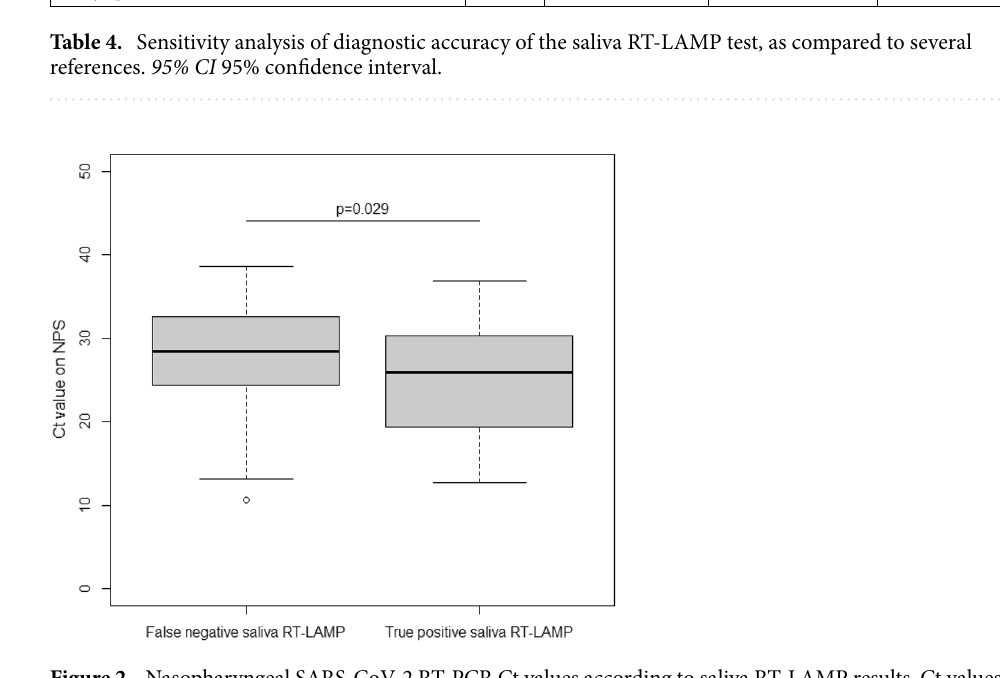
Figure 2. Nasopharyngeal SARS-CoV-2 RT-PCR Ct values according to saliva RT-LAMP results. Ct values of SARS-CoV-2 RT-PCR on nasopharyngeal samples (NPS) in individuals with saliva samples negative with the RT-LAMP assay (False negative) and those with saliva samples positive with the RT-LAMP assay (True positive) are presented in